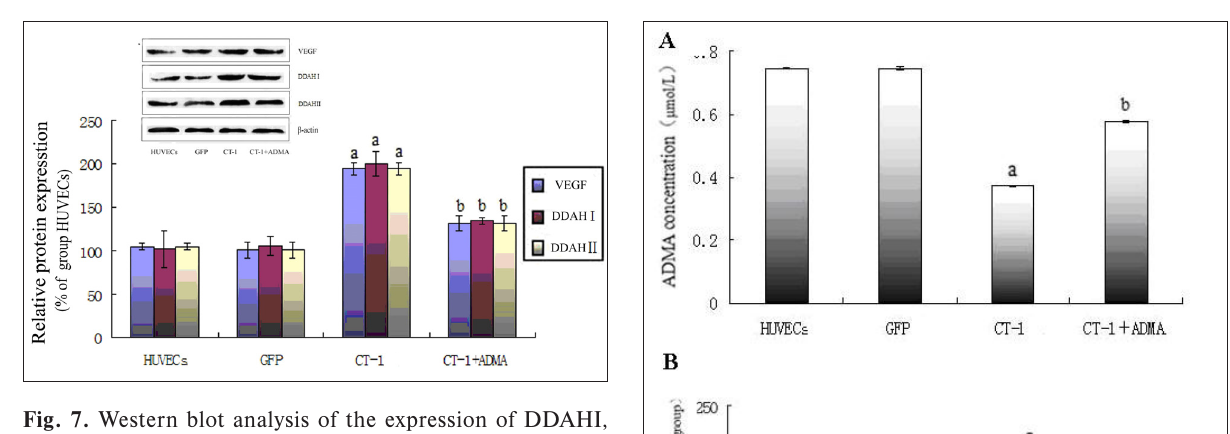
HUVEC group. n=3. Mean±SD. b P <0.05 vs CT-1 groups.